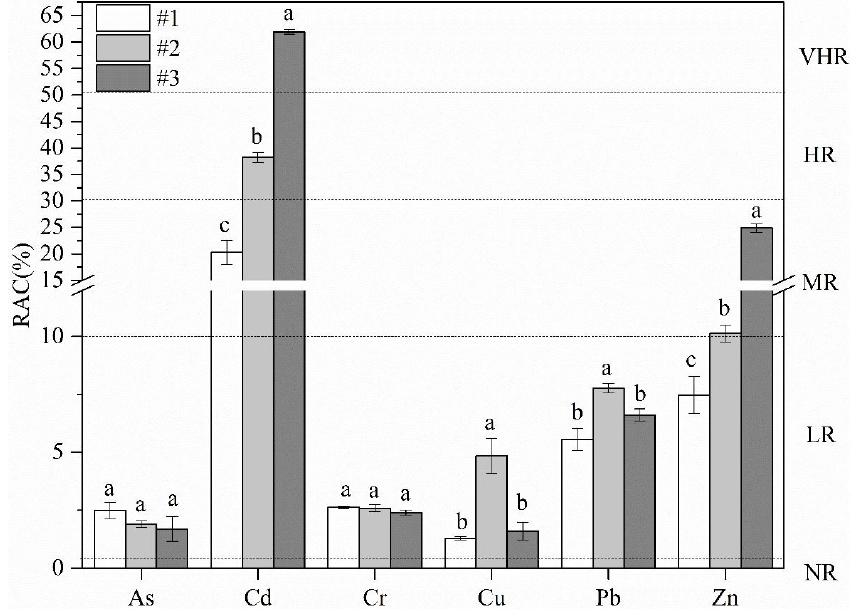
Figure 5. Difference of risk assessment code (RAC ± SD) and statistical test ( p < 0.05) between three abandoned sites. VHR = very high risk; HR = high risk; MR = medium risk; LR = low risk; NR = no risk. Bars marked with same letter are not significantly different at p = 0.05.